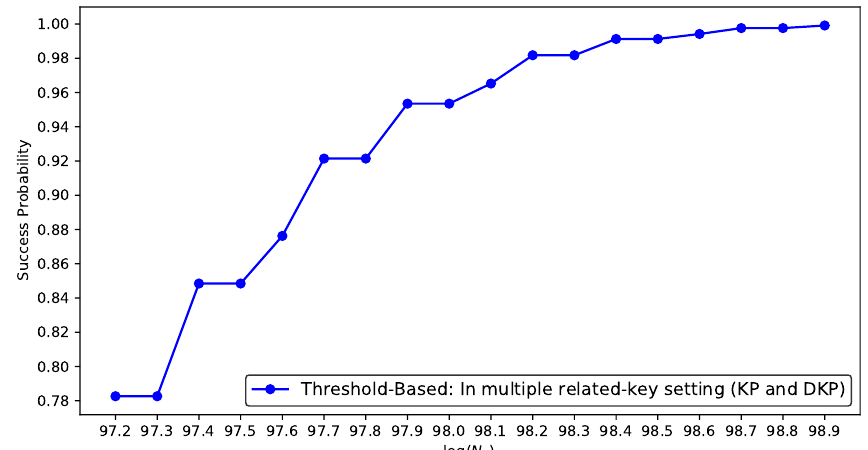
Figure 10: Success probabilities of multiple related-key attacks on TinyJAMBU using threshold-based